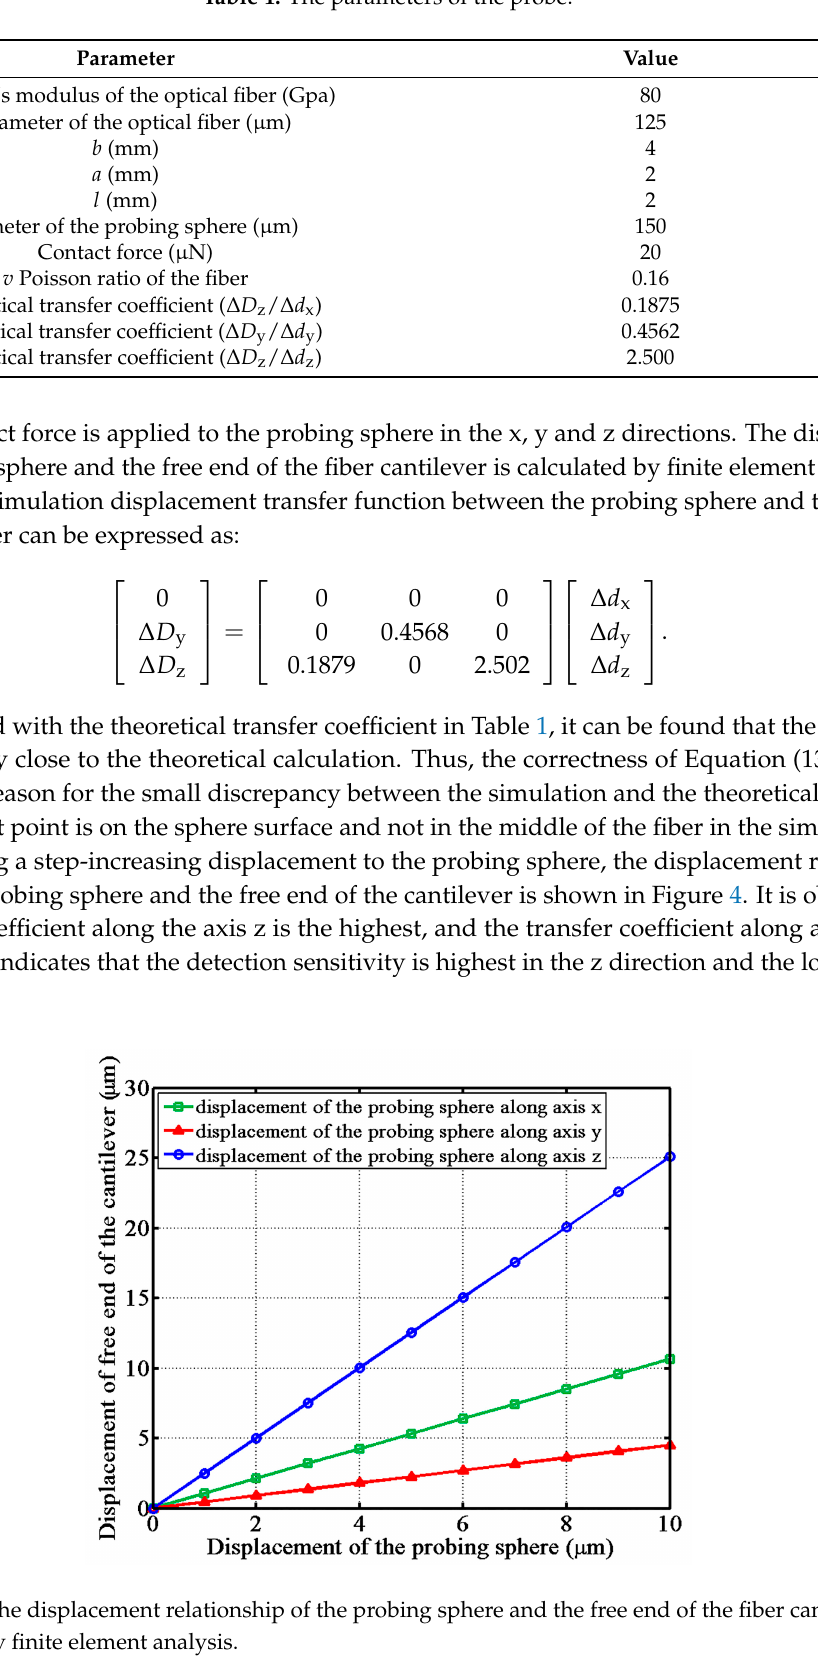
Table 1. The parameters of the probe.